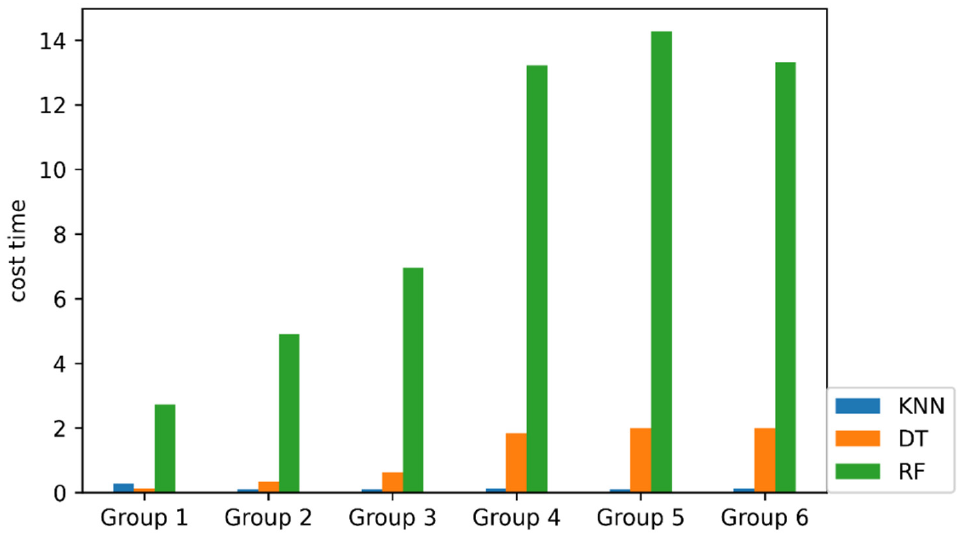
Figure 5. Execution time of different algorithms.